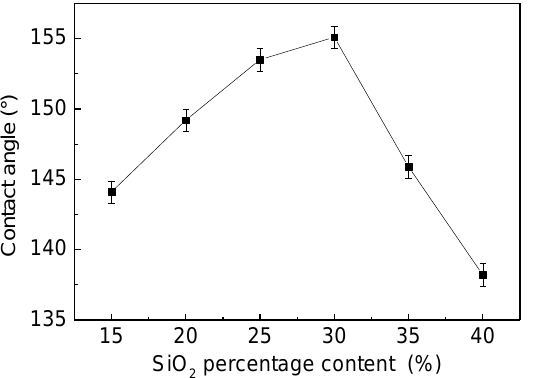
Figure 3. The relationship between the mass of SiO 2 and water contact angles. The phenolic resin amount was amount was 5%.